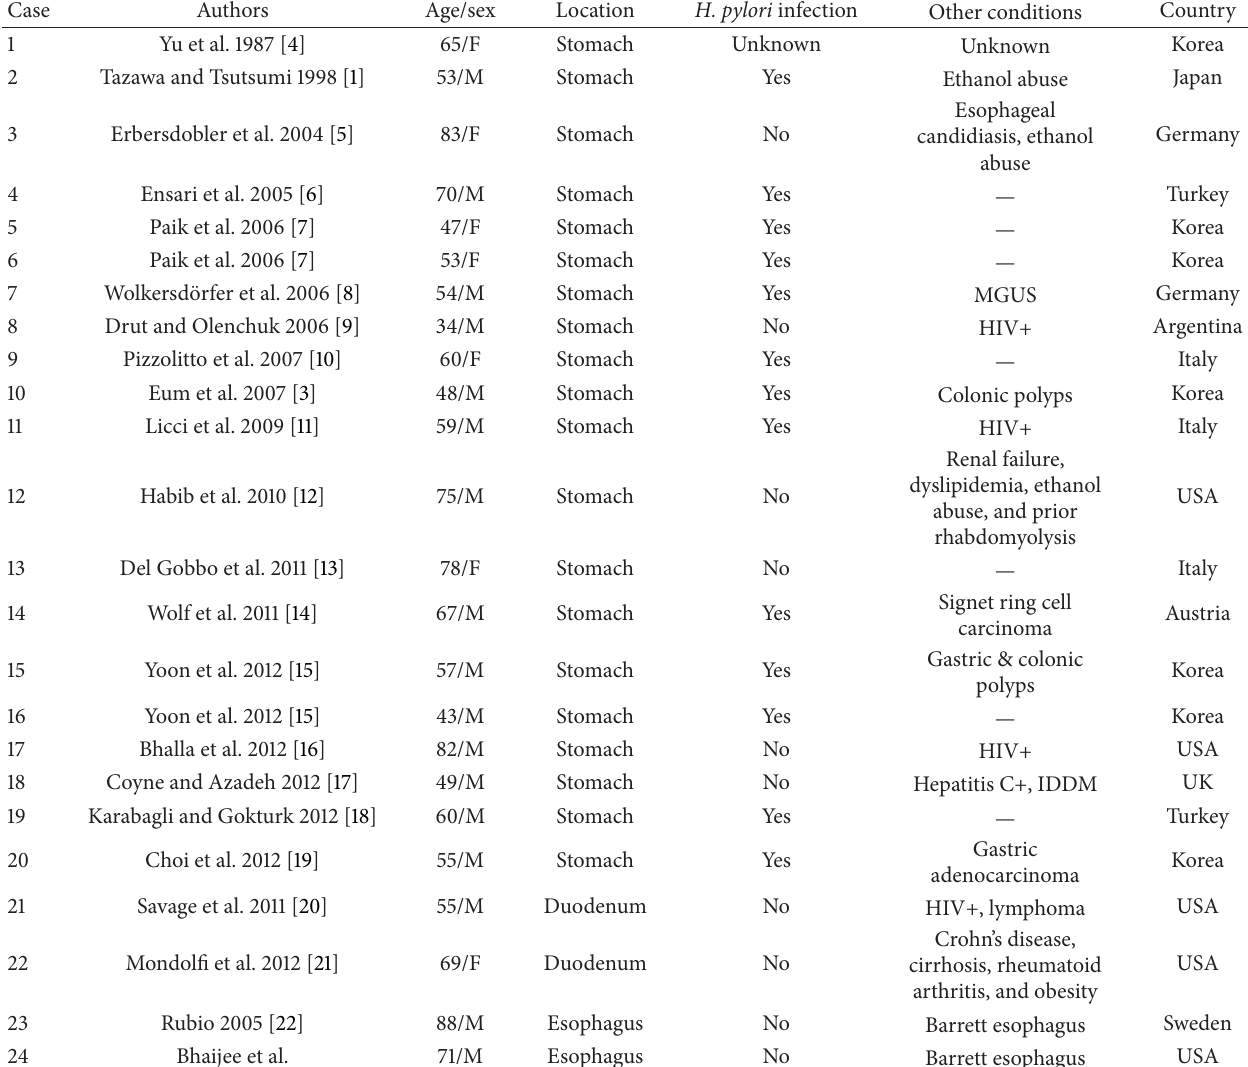
Table 1: Reported cases of Russell body gastritis, duodenitis, and Barrett